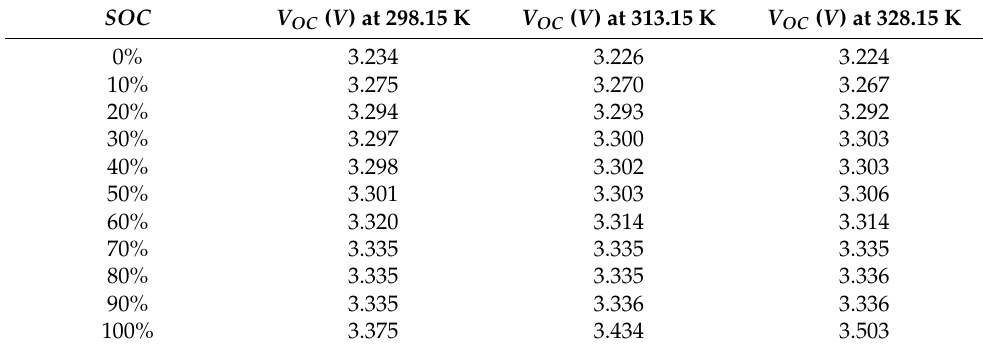
Table 2. Cell open circuit voltage.